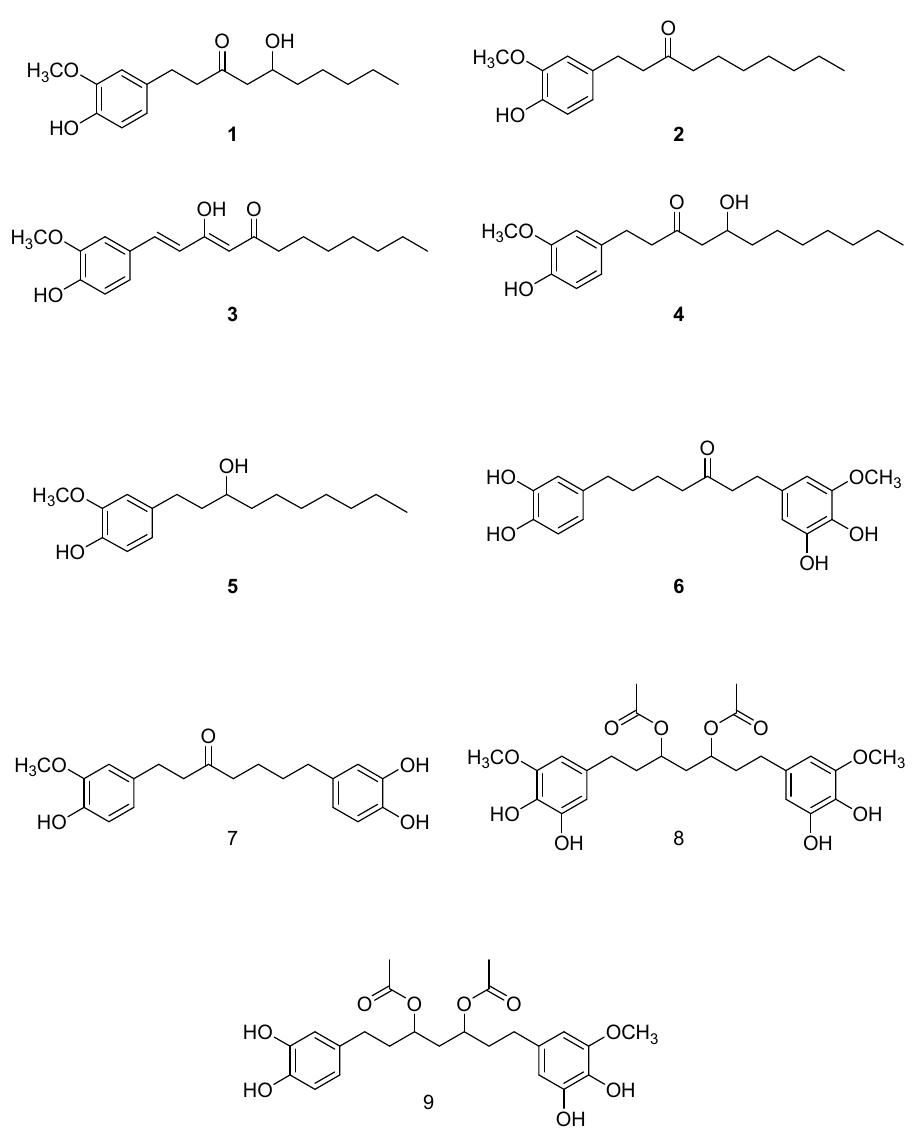
Figure 1. Isolated compounds from Aframomum meleguta.